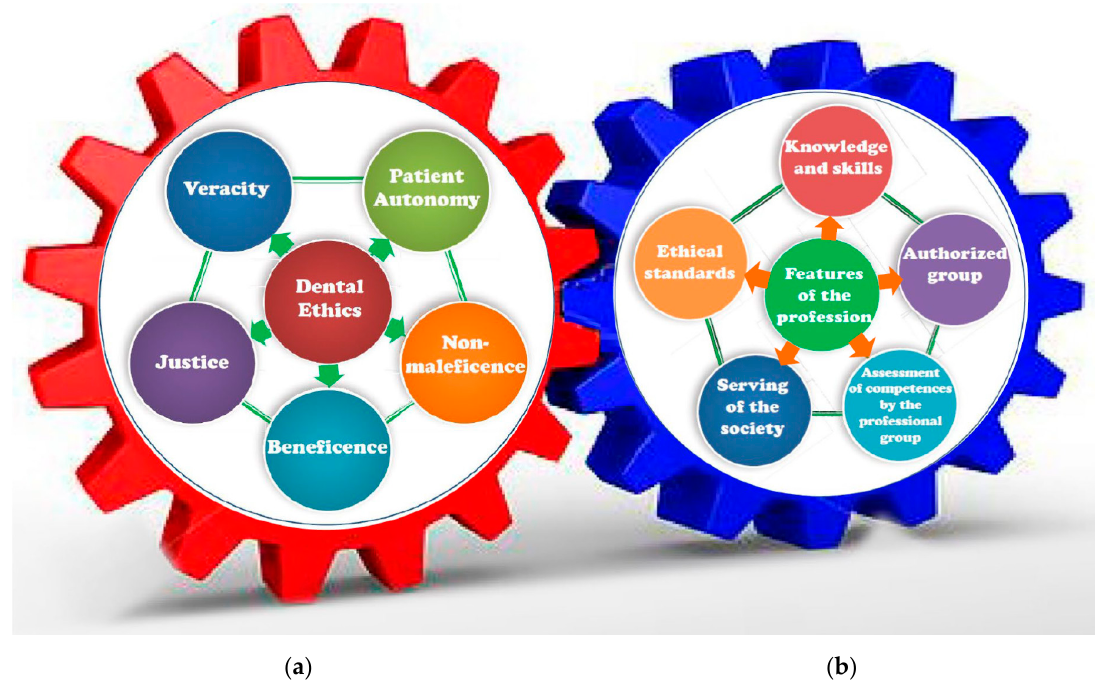
Figure 37. Diagram of the basic principles of dental ( a ) and engineering ( b ) ethics in the form of gears symbolizing the necessary cooperation between these areas.